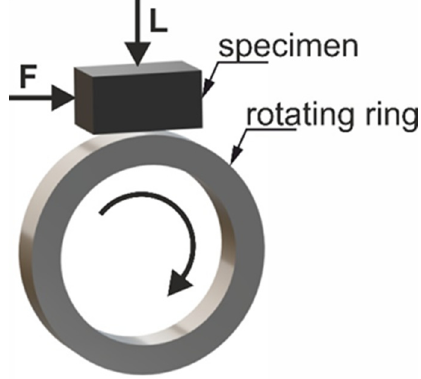
Figure 3. Diagram of the test using T-05 tribometer.